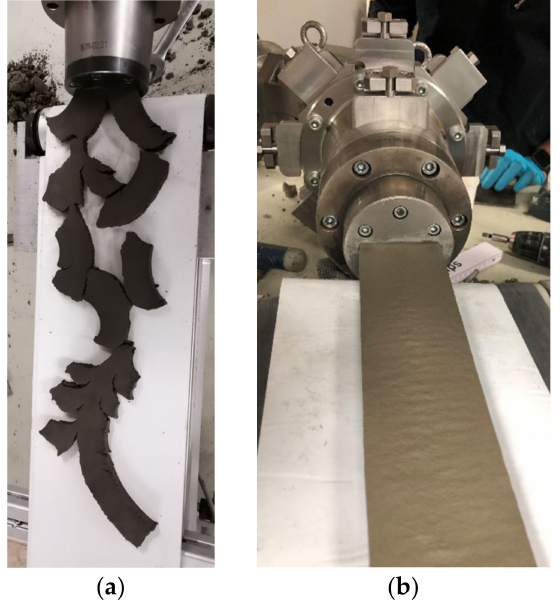
Figure 5. ( a ) Example of an unsuitable mixture for the extrusion process; ( b ) Example of a suitable mixture in the extrusion process with Mouthpiece